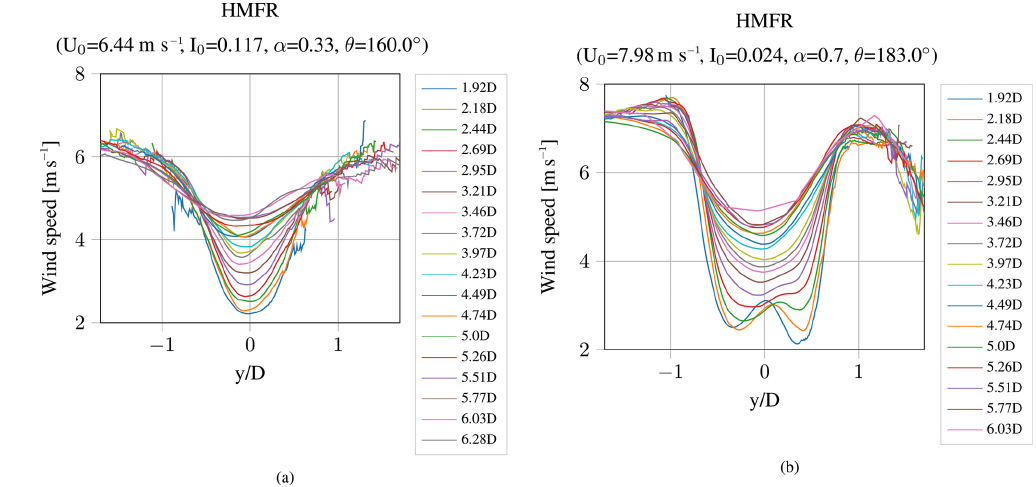
Figure 9. Wind speed deficit in the HMFR for an ambient turbulence intensity of 11.7% (a) and a turbulence intensity of 2.4% (b)